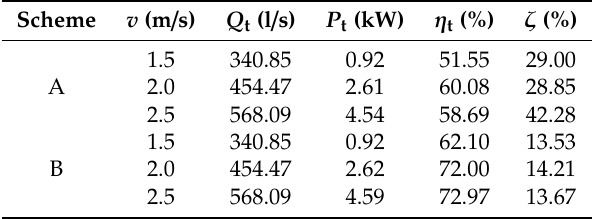
Table 1. Influences of di ff erent connection way on external parameters of the turbine.